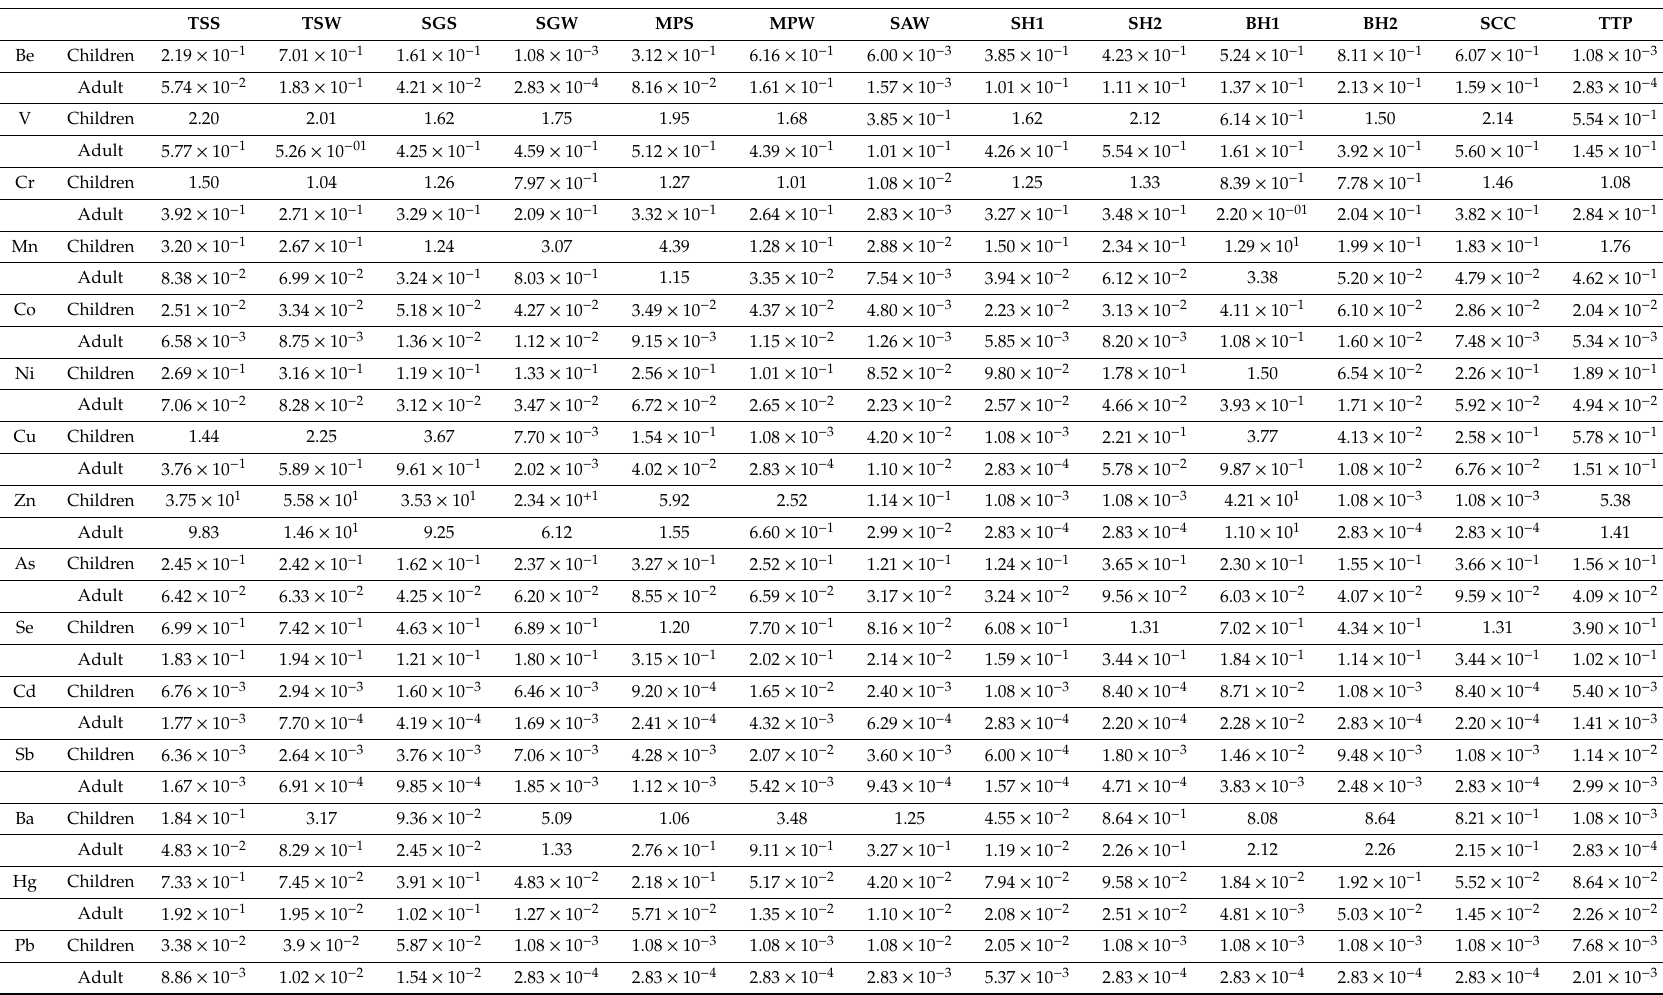
Table 7. Average chronic daily intake (CDI) values, in mg / kg / day, of geothermal water and boreholes for adults and children within Soutpansberg. TSS TSW SGS SGW MPS